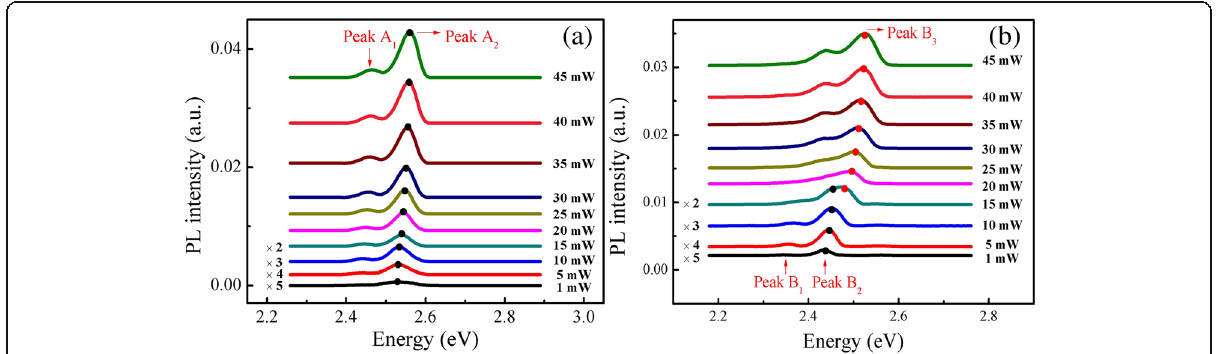
Fig. 3 PL spectra of samples A ( a ) and B ( b ) at several different excitation powers, measured under temperatures of 10 K